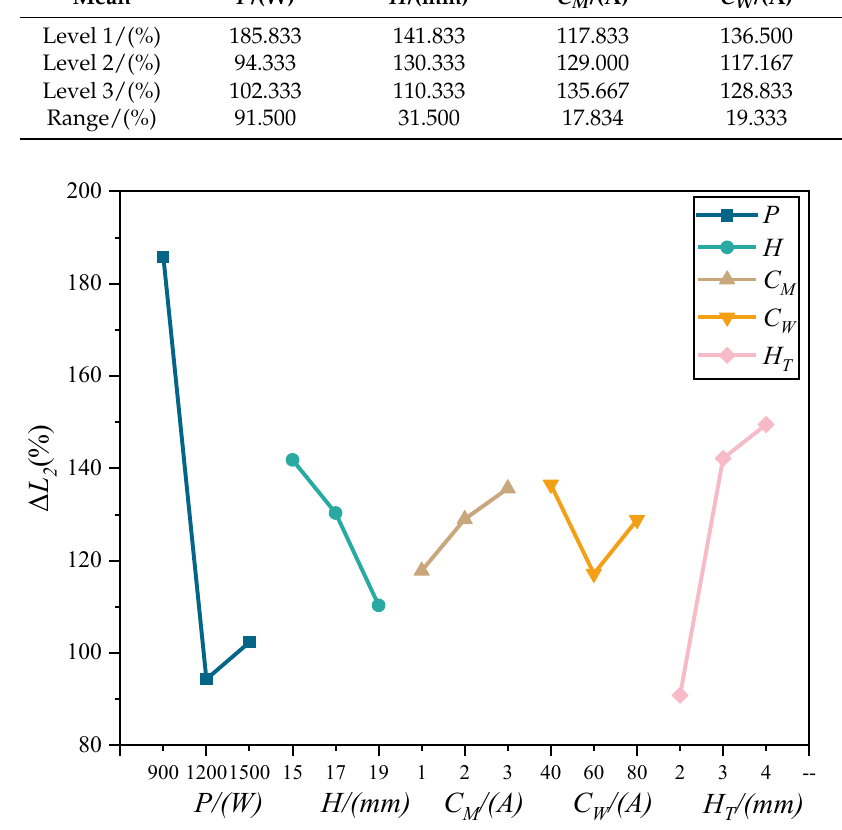
Figure 7. Trend diagram of ∆ L 2 with the variation of process parameters.